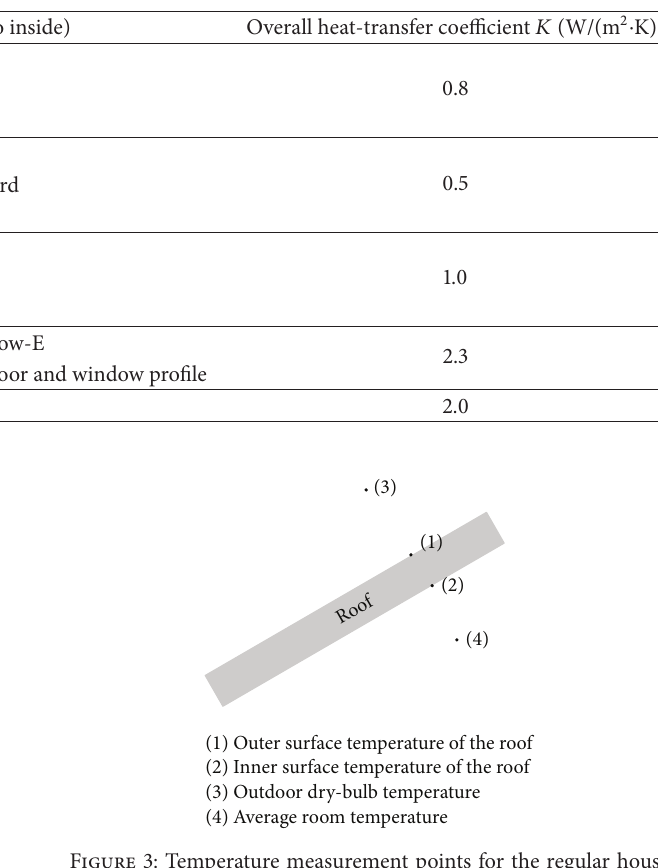
Table 1: Overall heat-transfer coefficients for the BIPV house.